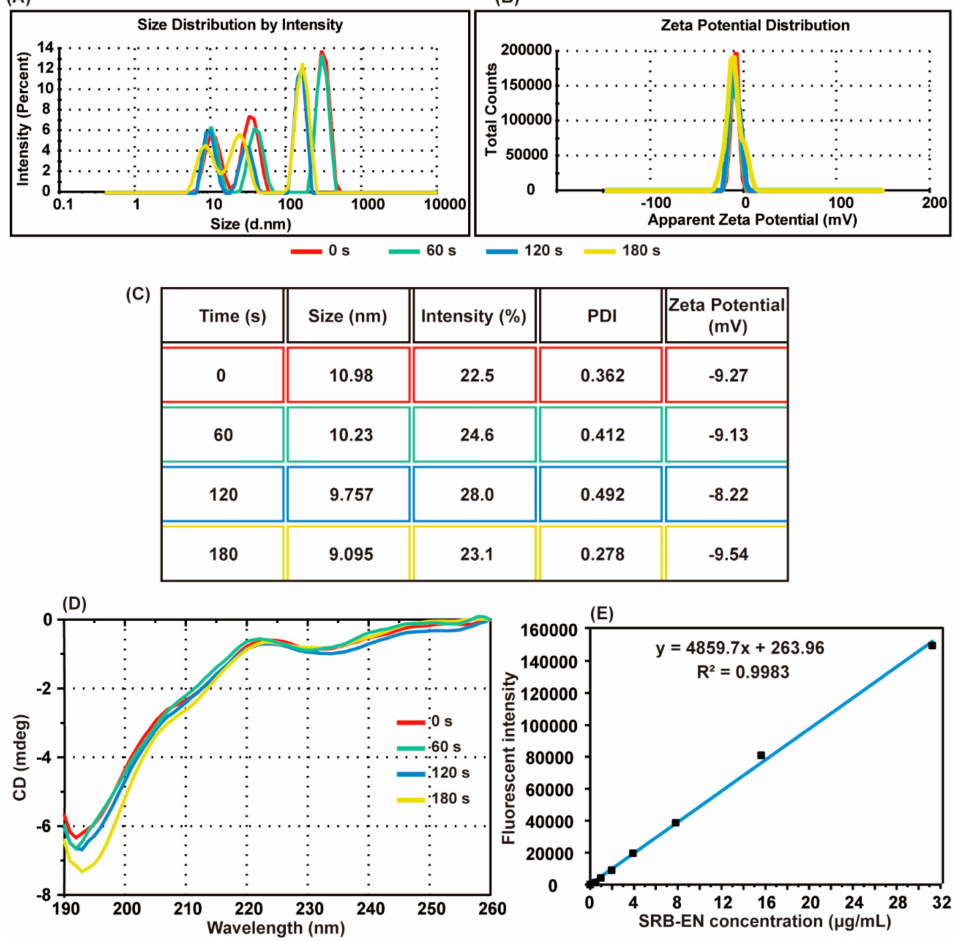
Figure 4. Size distribution by intensity ( A ) and zeta potential distribution ( B ) of EN after the exposure to Ultra Violet (UV) light for 0 s, 60 s, 120 s, and 180 s; ( C ) the table of size, intensity, polydispersity index, and zeta potential of the listed samples; ( D ) circular dichroism spectrum of listed samples; ( E ) a standard curve of the fluorescent intensity for SRB-EN